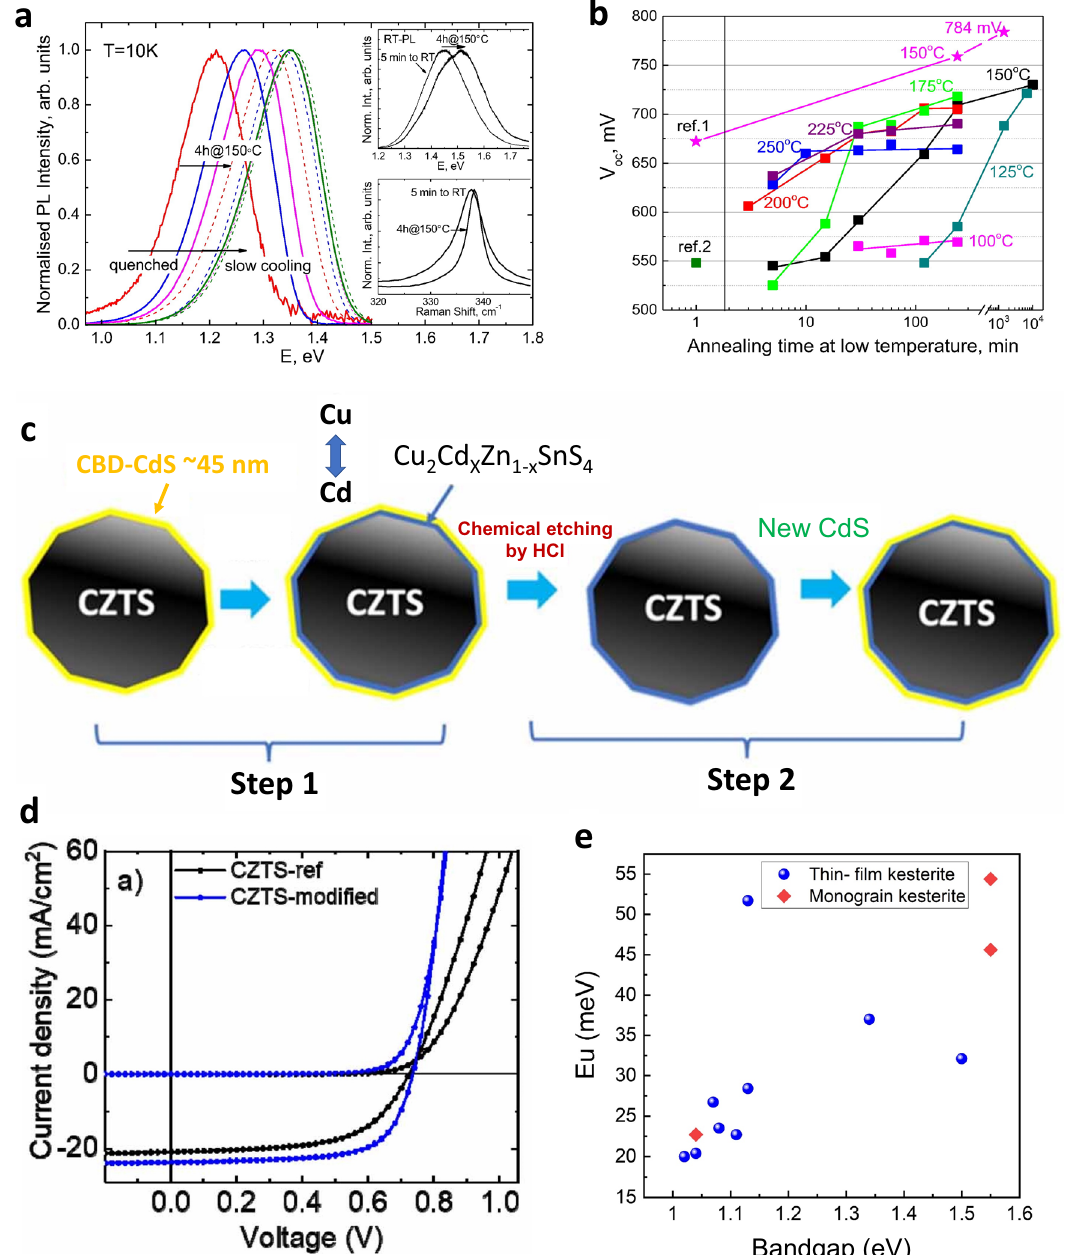
Fig. 5 Key post treatment steps for CZTSSe monograins and the device performance. a , b Evolution of photoluminescence (PL) and open circuit voltage (V OC ) of CZTS monograin layer solar cells after annealing at low temperature (ordering treatment), respectively. Reproduced with permission 80 . Copyright 2016, Elsevier B.V. All rights reserved. c Processing steps of surface CdS treatment for CZTS monograin layer solar cells. d Dark and illuminated current density-voltage curves of the CZTS monograin layer solar cells with and without CdS surface treatment. Reproduced with permission 81 . e Plot of Urbach energy ( E u ) against bandgap of representative CZTSSe monograin layer solar cells and thin- fi lm solar cells. The values of E u are listed in Table